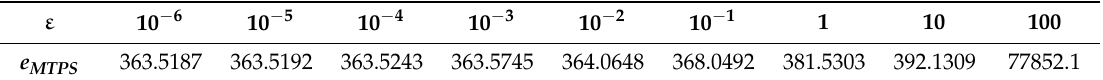
Table 1. Effect of correction coefficient in the accuracy of the modified TPS method.